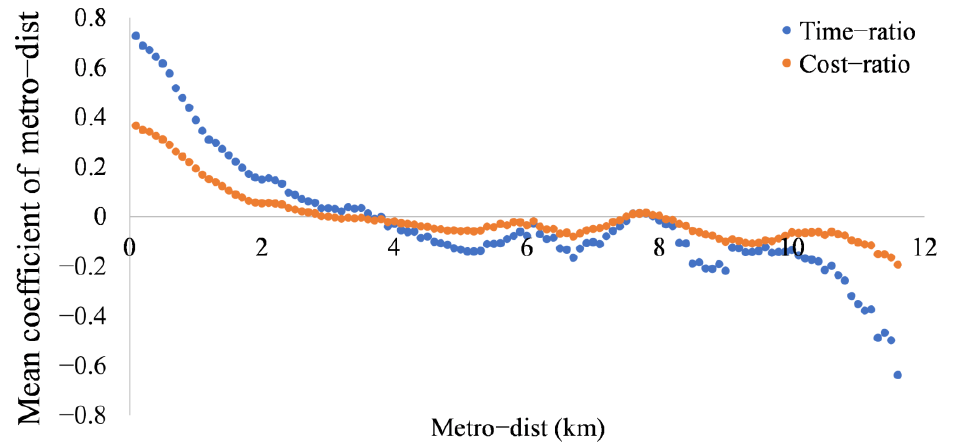
Figure 10. Mean coefficient of metro-dist for units within the same range from the metro stations.